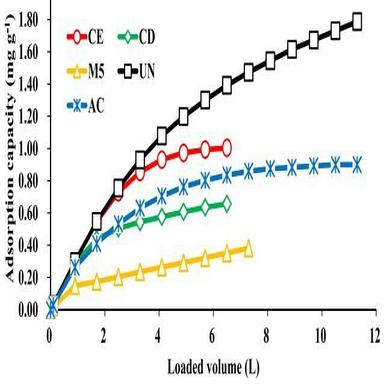
Adsorption capacities of the tested adsorbents toward low FA concentrations (0.1–0.5 ppm) (ambient temperature and 2 mg adsorbents).